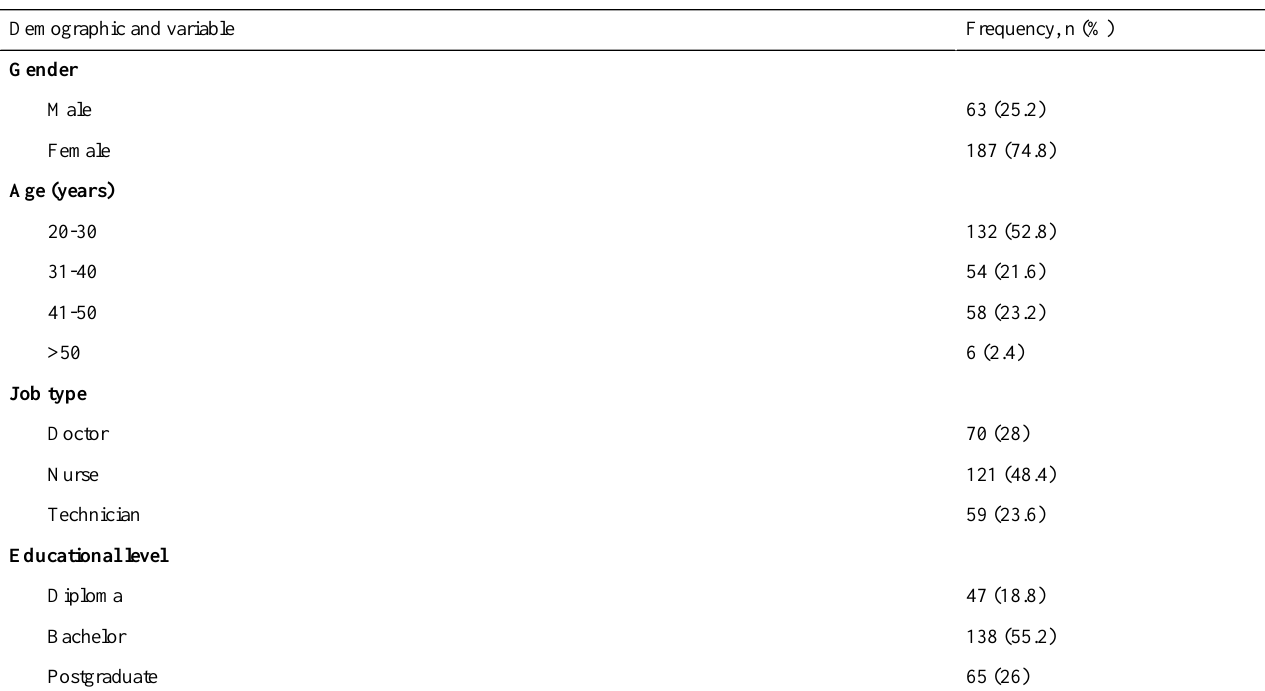
Table 2. Respondent demographics